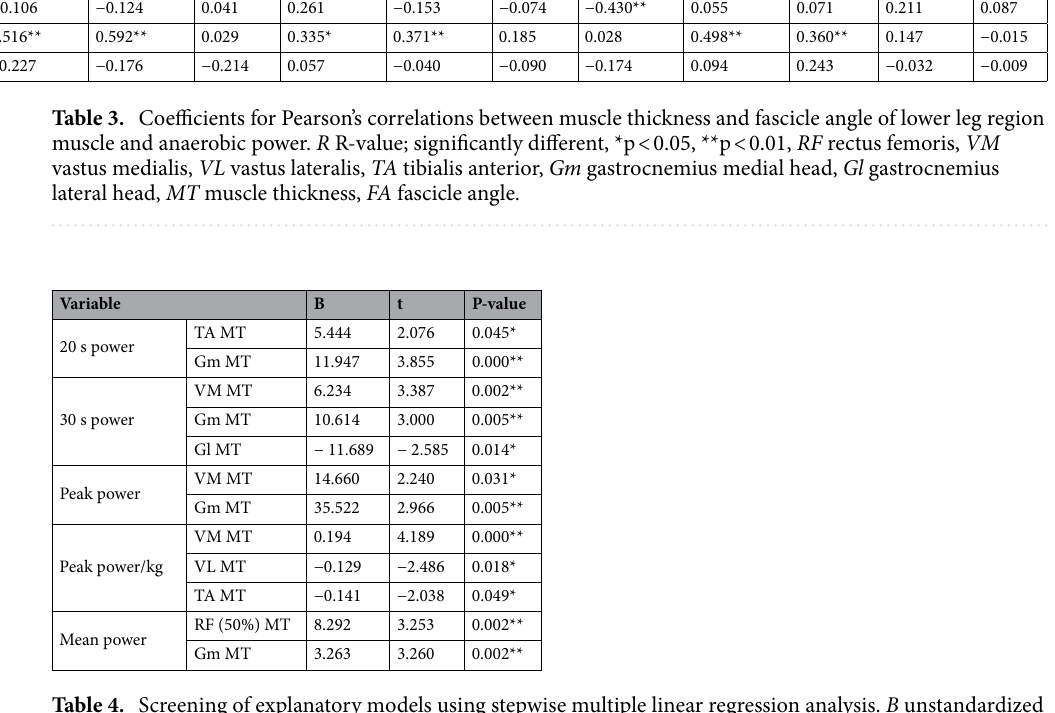
Table 4. Screening of explanatory models using stepwise multiple linear regression analysis. B unstandardized coefficient, t t statistic; significantly different, **p < 0.01, *p < 0.05, MT muscle thickness, RF rectus femoris, VM vastus medialis, VL vastus lateralis, TA tibialis anterior, Gm medial head of gastrocnemius, Gl lateral head of